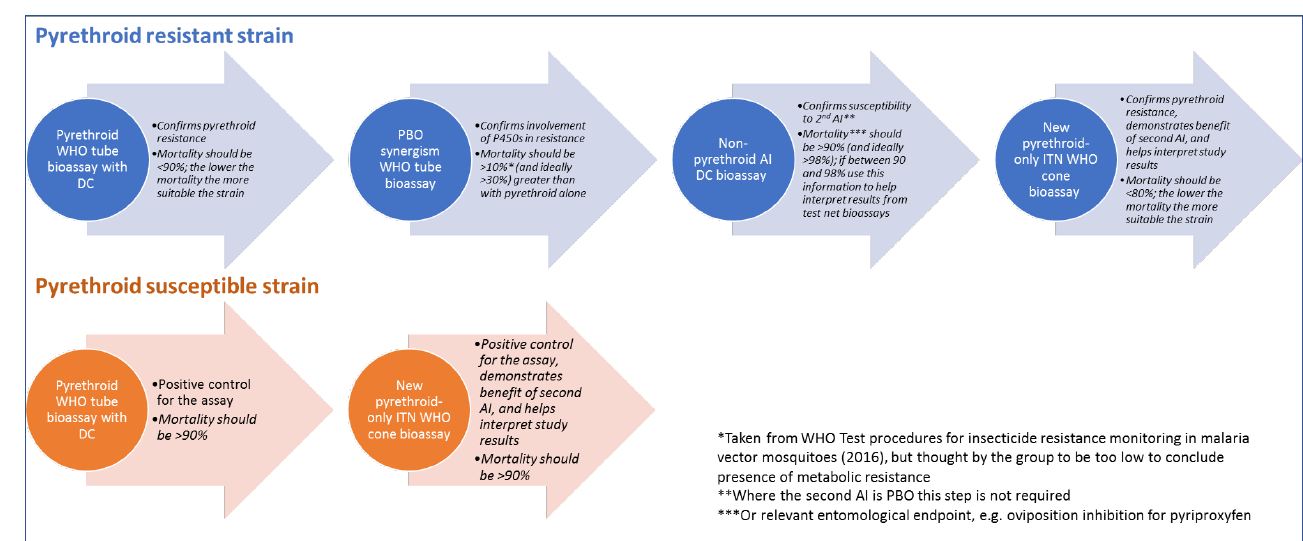
Figure 1. Overview of protocol for characterisation of a pyrethroid resistant strain for use in testing the bioefficacy of a dual-AI ITN, developed by consensus of a group of key stakeholders. Where delayed mortality (scored after more than 24 h) is the endpoint of interest for the second AI, mortality should be scored at this later time point for all elements of the characterisation; mortality may also be scored at 24 h.